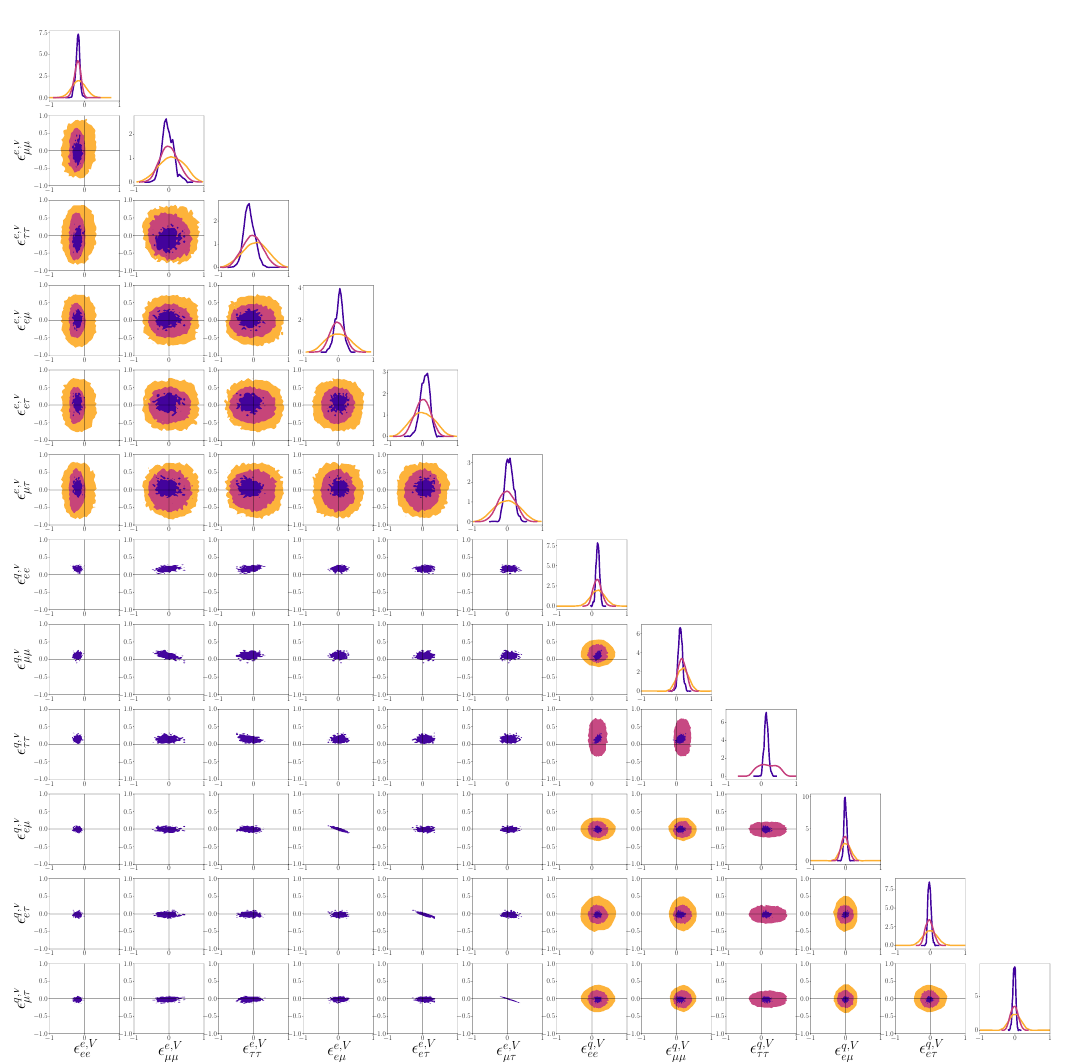
Figure 11 . 1-dimensional marginals and 95% credible contours for the 2-dimensional marginal projections are shown for each stage in the prior-(cid:13)ow, but now reduced to 12 NSI degrees of freedom by summing (cid:15) u;V + (cid:15) d;V (cid:15) q;V . The (cid:12)rst stage (yellow) consists of COHERENT and Borexino. (cid:11)(cid:12) (cid:11)(cid:12) (cid:17) (cid:11)(cid:12) The second stage (magenta) consists of the future LXe projection for atmospheric neutrinos and solar neutrinos and takes in priors from the (cid:12)rst stage. The (cid:12)nal result at the last stage (indigo) uses atmospheric neutrinos at DUNE and takes in priors from the second